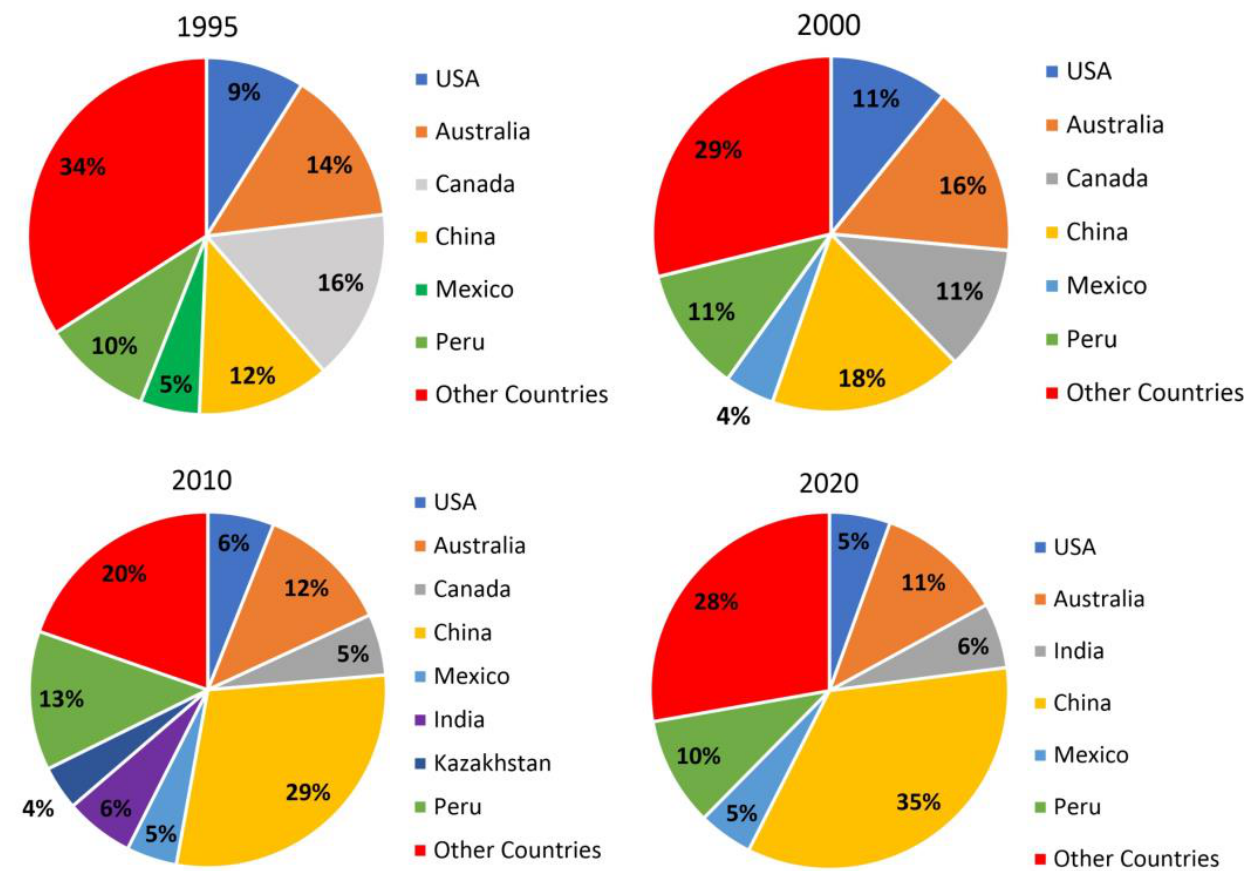
Figure 2. Zinc mine production in 1995 – 2020, figures worked out based on data from [19,29 – 31].